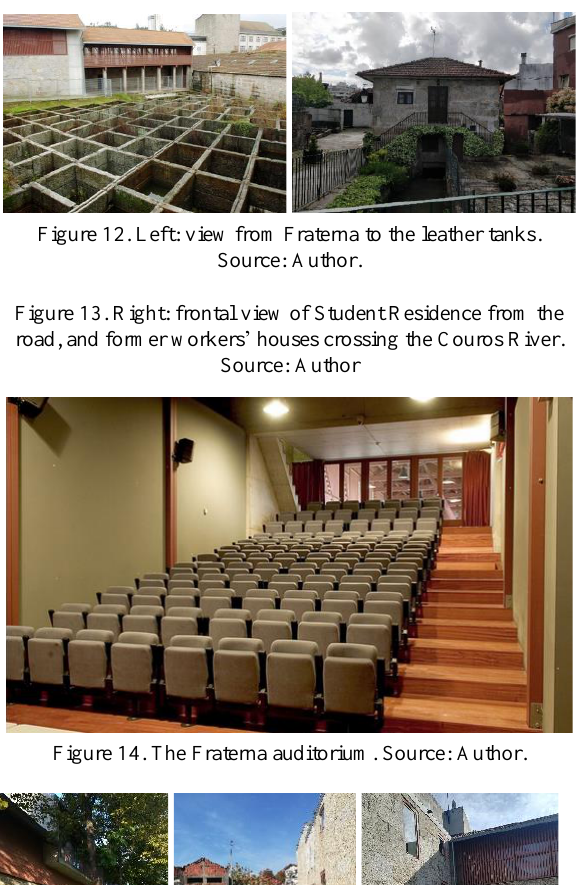
Figure 14. The Fraterna auditorium. Source: Author.